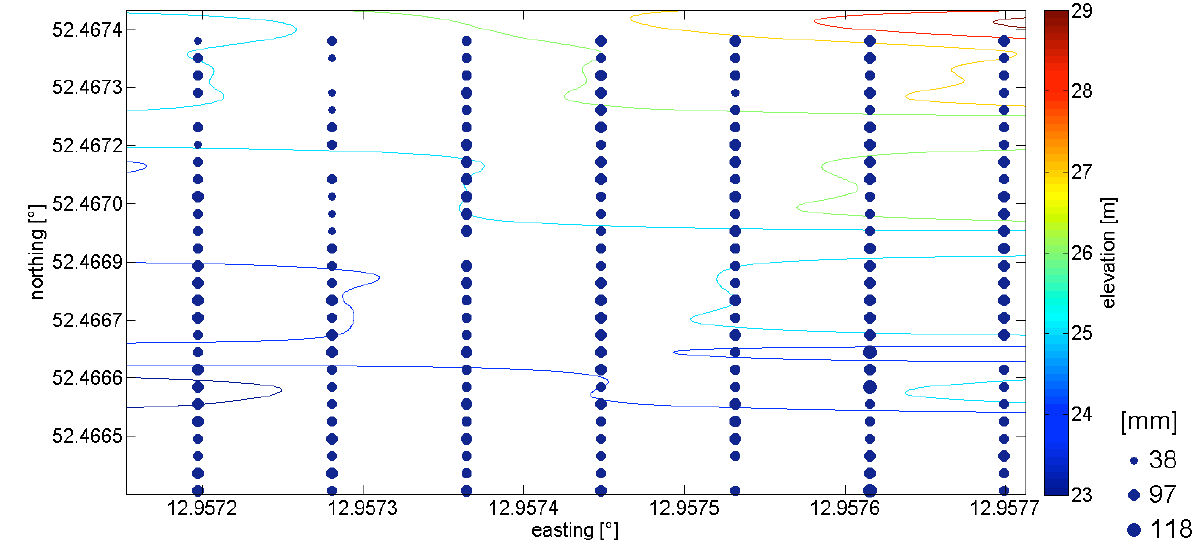
Figure 1. Layout of the cherry